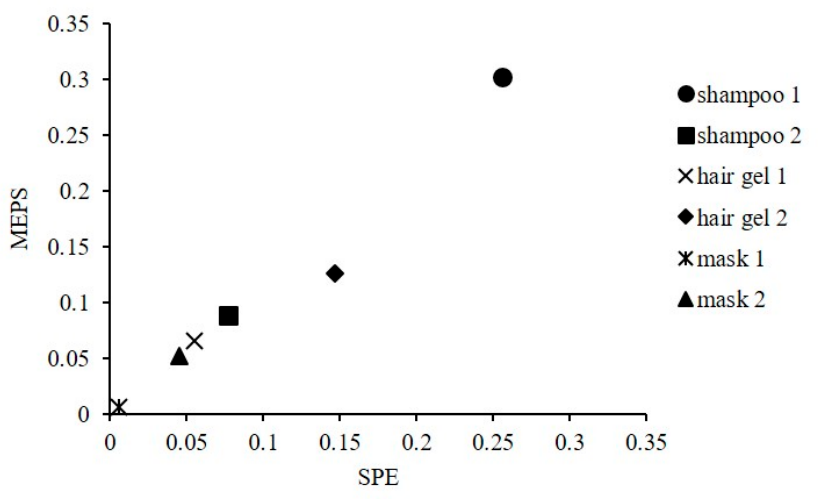
Figure 3. Comparison of BP-3 concentrations (%) in cosmetics samples determined by SPE and MEPS methods with GC-MS analysis.